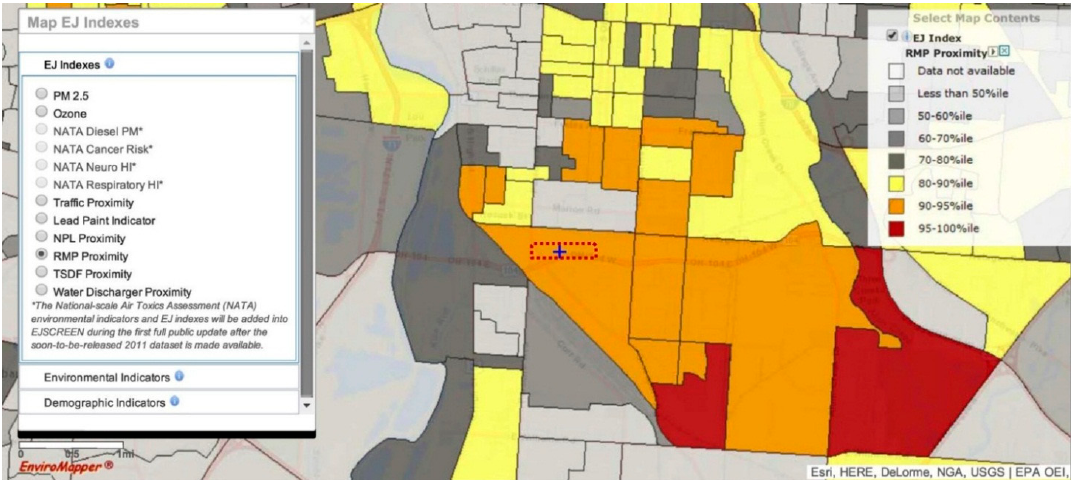
Figure 3. EPA-EJSCREEN portal. Stambaugh-Elwood (SE) population ( n = 150) is in the 90–93 percentile for the proximity to a facility with a Risk Management Plan (RMP). The red rectangle denotes the SE neighborhood. EJ: environmental justice; The National-scale Air Toxics Assessment (NATA); Proximity National Priority List Sites (NPL); Proximity to Treatment Storage and Disposal Facilities (TSDF)